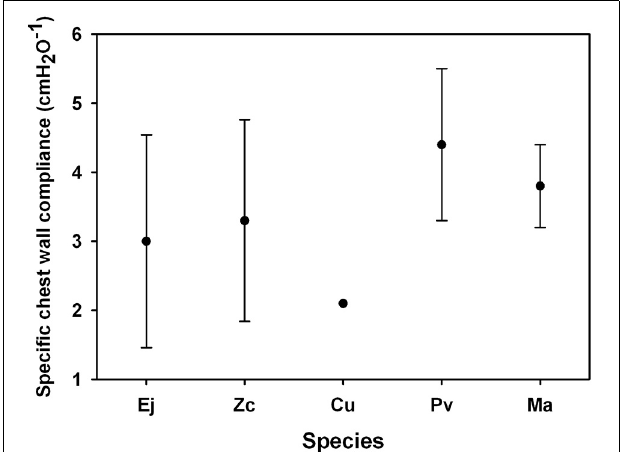
FIGURE 3 | Average specific chest compliance [the lung compliance divided by the estimated residual volume (RV), where RV was assumed equal to the Minimum Air Volume which was an average 7% of total lung capacity in excised lungs (Fahlman et al., 2011)] for captive Steller sea lions (Ej, Eumetopias jubatus ), California sea lion (Zc, Zalophus californianus ), Northern fur seal (Cu, Callorhinus